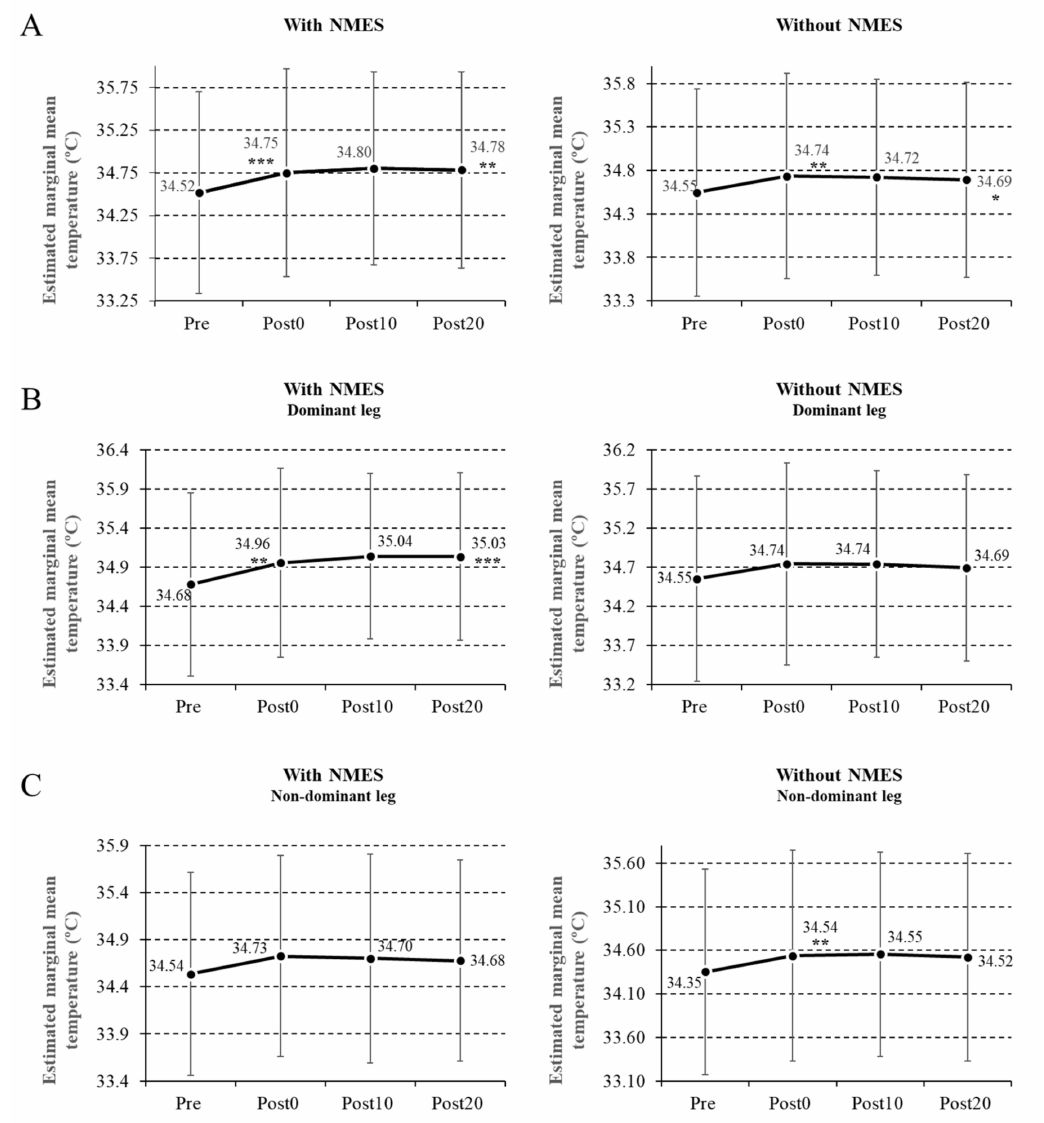
Figure 2. Variations of maximum temperature in the leg subjected to neuromuscular electrostimulation (NMES) and in the contralateral leg ( A ); temperature variations in both legs when the NMES was applied in the dominant leg ( B ); temperature variations in both legs when the NMES was applied in the nondominant leg ( C ). Data are reported as mean ± SD (error bars), and p -values reported are those following Bonferroni correction (* p < 0.05; ** p < 0.01; *** p <